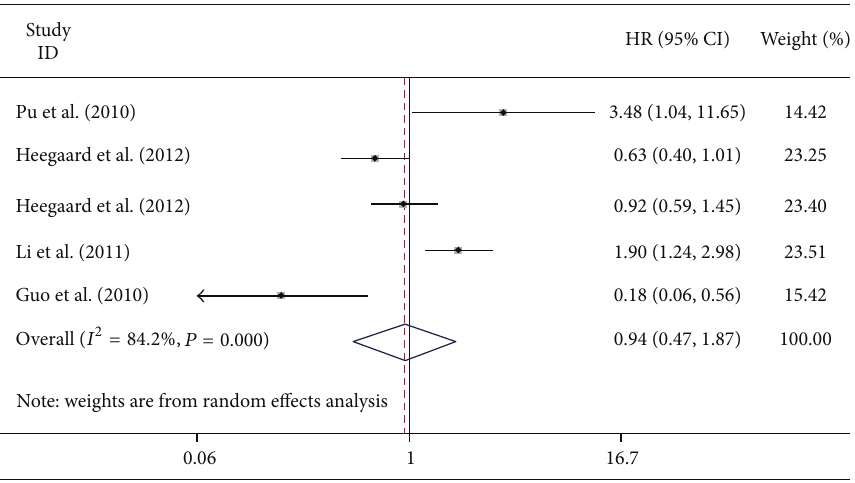
Figure 2: Forrest plots of overall survival in cancer patients evaluating hazard ratios of high miR-221 expression as compared to low expression. Diamonds indicate pooled OR in single study; horizontal bars indicate 95%